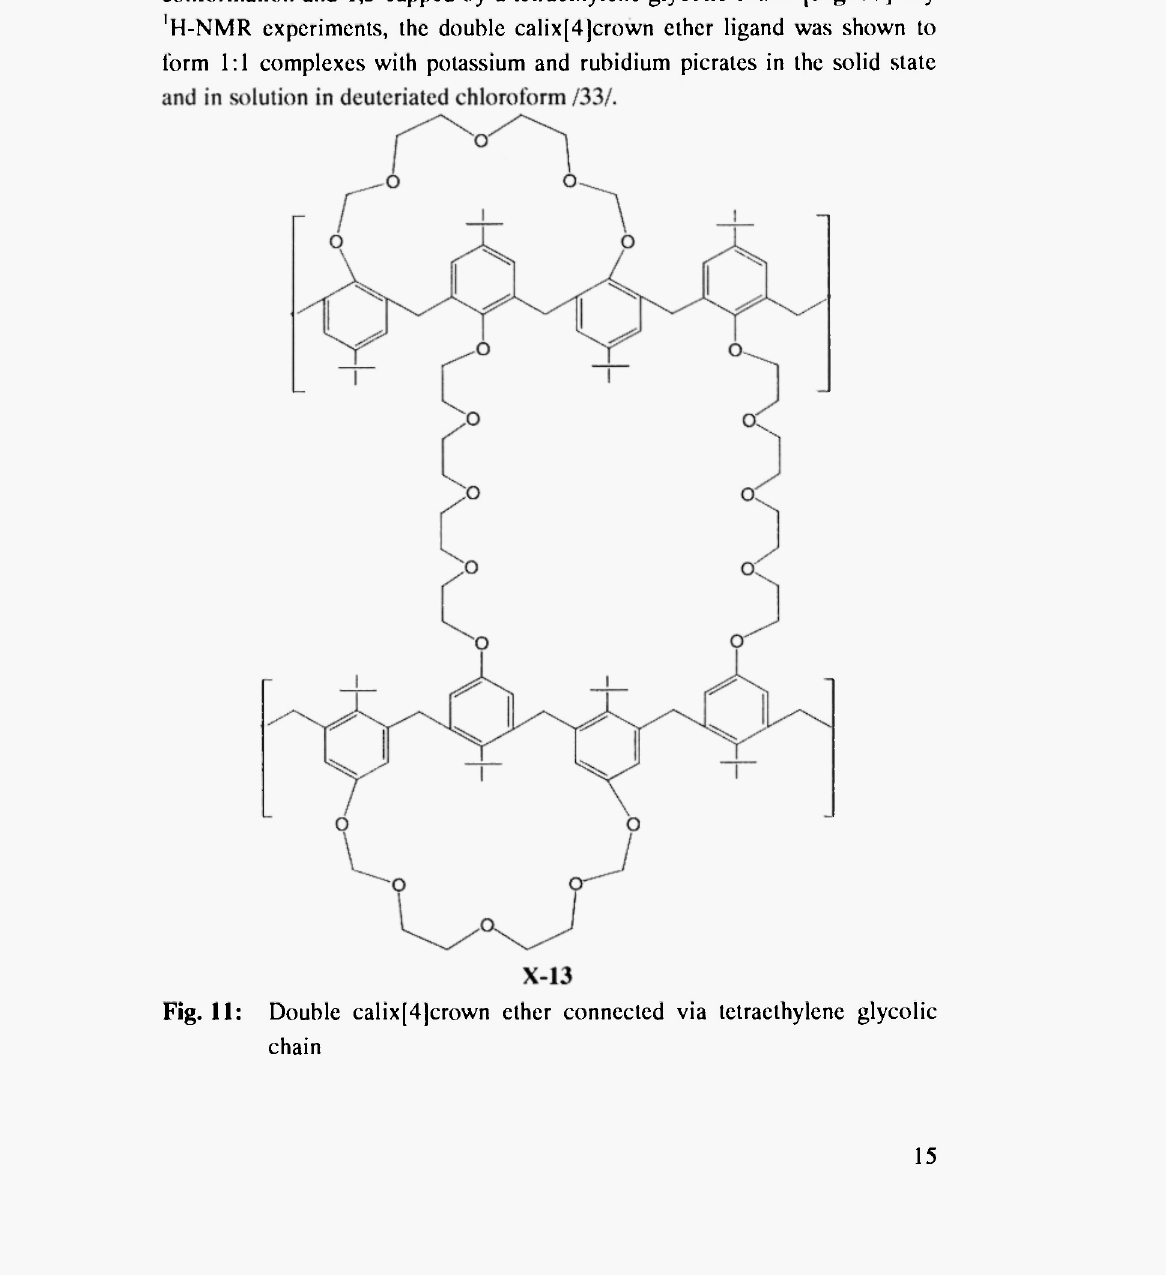
Fig. 11: Double calix[4]crown ether connected via tetraethylene glycolic chain